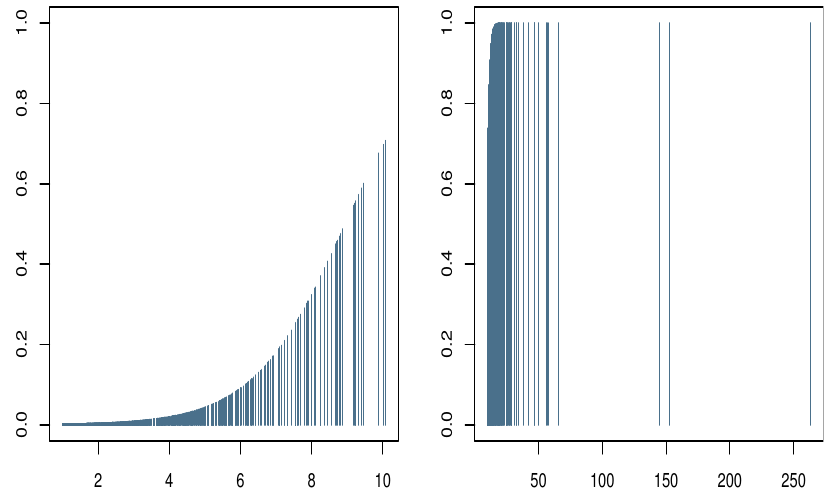
Figure 4. Posterior probability that each observation is unusual, corresponding to DS1 dataset. ( Left ) panel is for the first 2060 observations and ( right ) panel for the 107 last